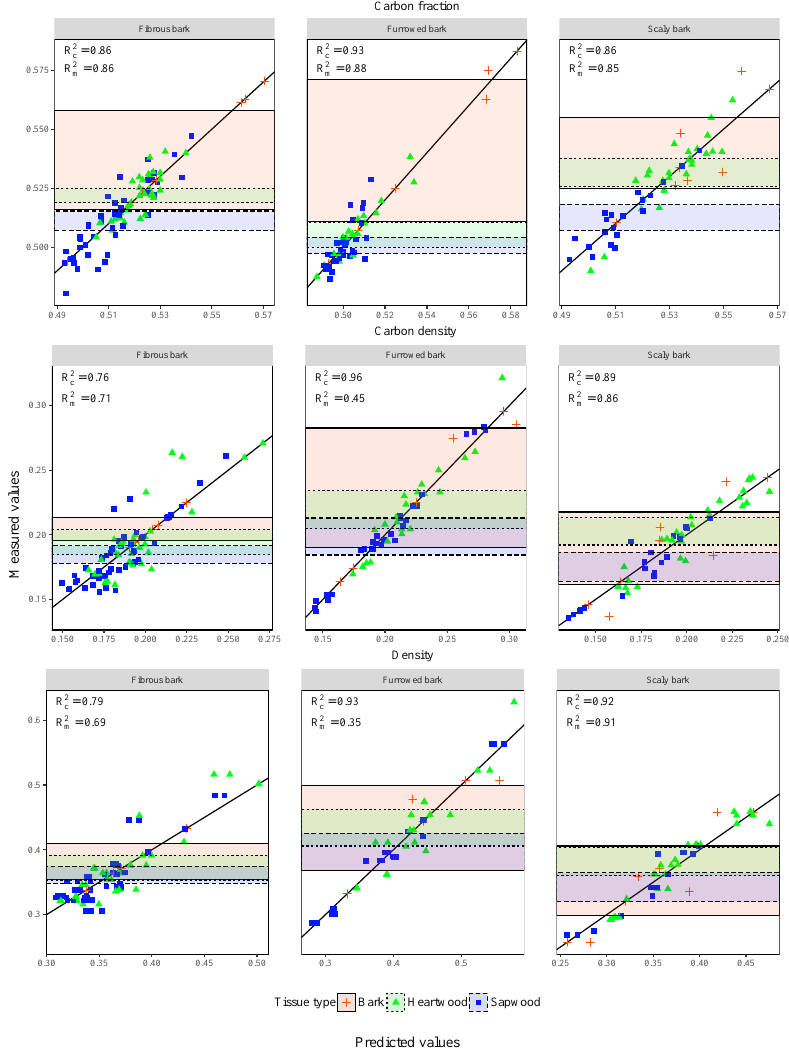
Figure 2. Measured values for carbon fraction, tissue density, and carbon density are shown relative to predicted values from the best-fit LME models from Table 6. R c2 values correspond to the proportion of variance explained by the fixed and random effects in the model, while R m2 values correspond to variance explained by the fixed effects alone. Data is grouped by bark characteristics and tissue types are differentiated by shapes and color. Shaded regions represent the 95% confidence interval in measured values for a given tissue type within a particular tree